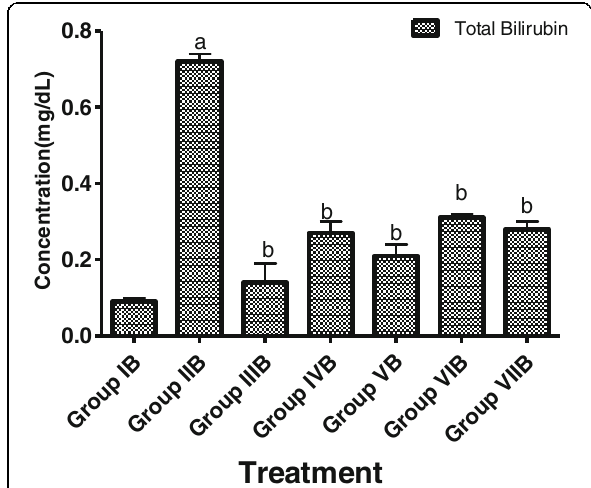
oup G r Fig. 7 Effect of methanol extract of T. conophorum seeds on Total Fig. 6 Effect of methanol extract of T. conophorum seeds on bilirubin in CCl 4 induced hepatotoxicity in rats after 48 h of Gamma gtutamyl transferase activities in CCl 4 induced intoxication. Values are Mean ± SEM, n = 5 rats in each group. p < hepatotoxicity in rats after 48 h of intoxication. Values are Mean ± 0.05, a as compared with the normal control group; b as compared SEM, n = 5 rats in each group. p < 0.05, a as compared with the with the CCl 4 only(group IIB), CCl 4 , Carbon tetrachloride. Group IB normal control group; b as compared with the CCl 4 only (group IIB). (control) received distilled water and olive oil (i.p), group IIB rats γ -GT – Gamma gtutamyl transferase CCl 4 - Carbon tetrachloride. were intoxicated with CCl 4 in olive oil (600 mg/kg, i.p.) only on the Group IB (control) received distilled water and olive oil (i.p), group 8th day, while groups IIIB, IVB and VB were given 100 mg/kg of IIB rats were intoxicated with CCl 4 in olive oil (600 mg/kg, i.p.) only silymarin, 250 mg/kg and 500 mg/kg of methanol extract, on the 8th day, while groups IIIB, IVB and VB were given 100 mg/kg respectively for 7 days, thereafter intoxicated with CCl 4 on the 8th of silymarin, 250 mg/kg and 500 mg/kg of methanol extract, day. Groups VIB and VIIB were intoxicated with CCl 4 on the 8th day respectively for 7 days, thereafter intoxicated with CCl 4 on the 8th and administered 250 mg/kg and 500 mg/kg of methanol extract of day. Groups VIB and VIIB were intoxicated with CCl 4 on the 8th day T. conophorum seeds at 1 h, 6 h, 12 h, 18 h and 24 h. Fasting blood and administered 250 mg/kg and 500 mg/kg of methanol extract of samples were collected after the last administration of the extract at T. conophorum seeds at 1 h, 6 h, 12 h, 18 h and 24 h. Fasting blood 48 h of intoxication with CCl samples were collected after the last administration of the extract at 48 h of intoxication with CCl 4